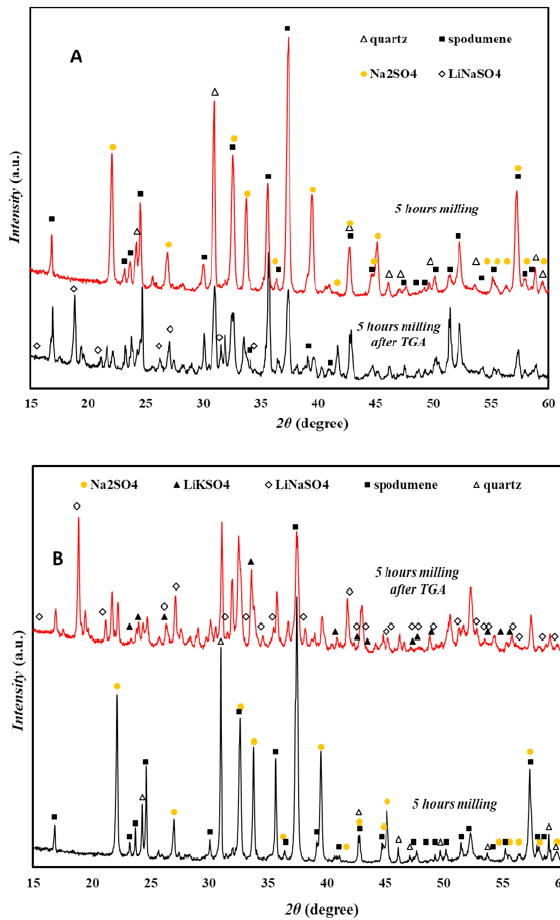
Fig. 4 . XRD patterns of TGA solid residues for spodumene- -Na SO mixtures with mass ratios of 1 : 0.5 (A) and 2 4